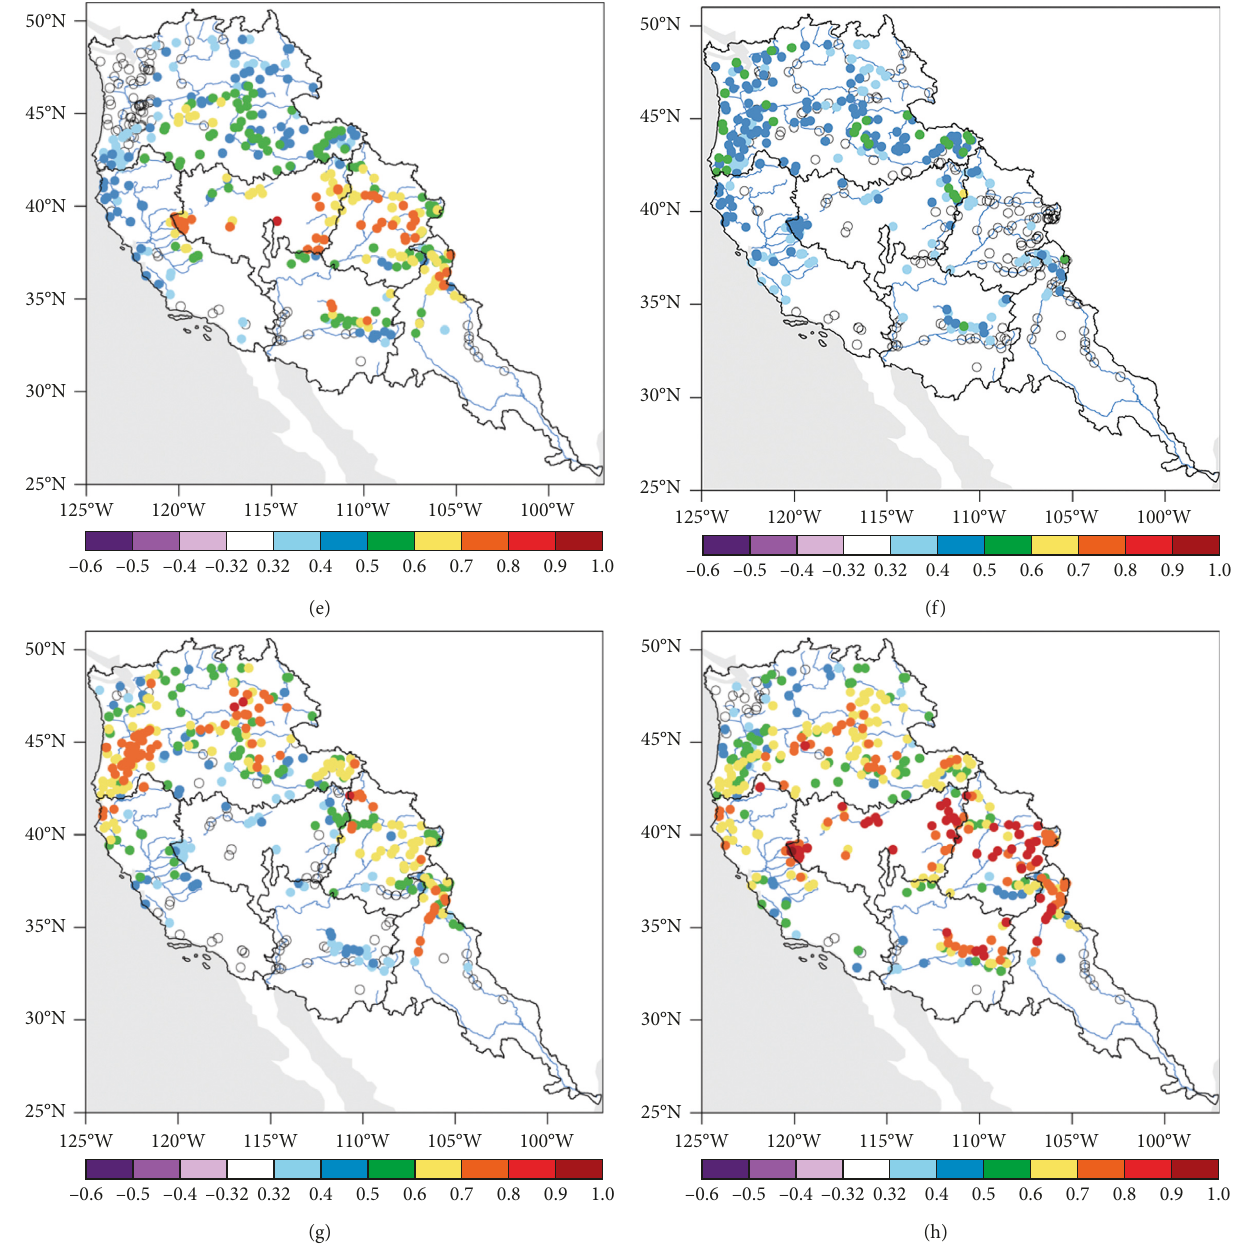
Figure 6: Distributions of the correlation coefficients between the snow metrics and peak streamflow in each watershed (1981–2016). Panels (a)–(h) represent different snow metrics: (a) the initial snow accumulation day, (b) snow-free day, (c) peak SWE value, (d) peak SWE day, (e) length of snow accumulation season, (f) length of snow melting season, (g) snow accumulation slope, and (h) snowmelt slope. Circles represent stations that did not pass the 95% significance